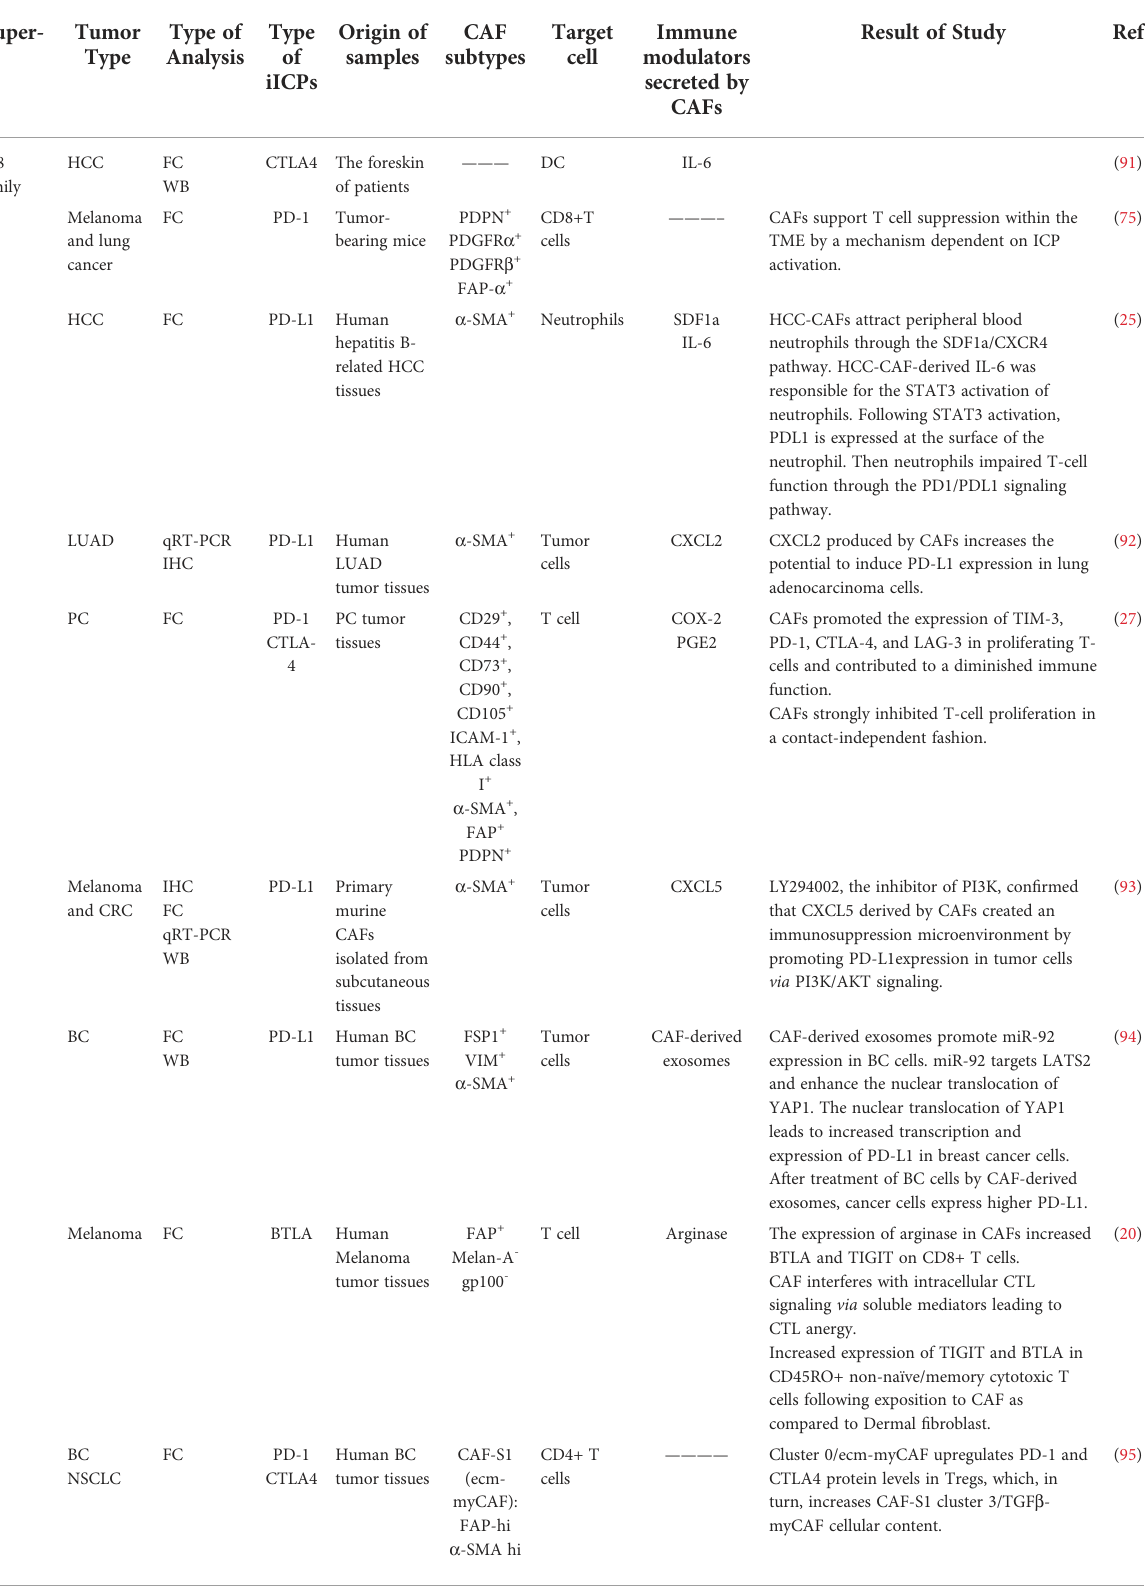
TABLE 2 Induction of iICPs and their ligands on the cell surface in TME by CAFs. ICP Super-